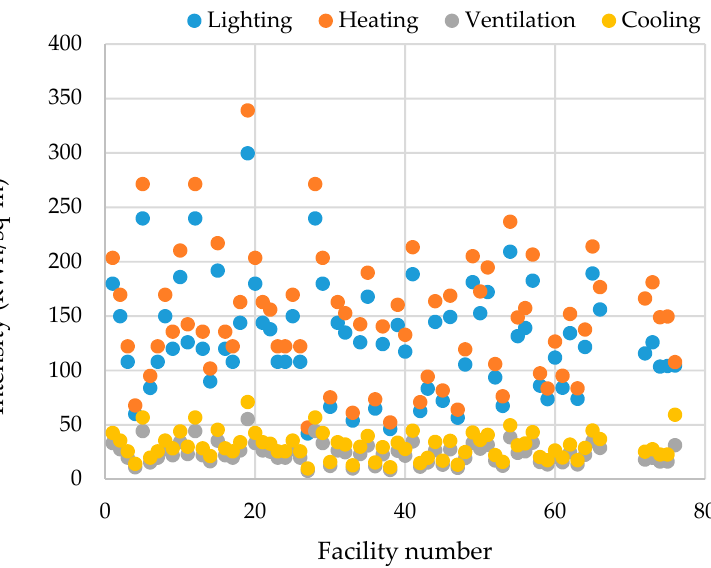
Figure 5. Healthcare facilities annual non-process energy intensity.